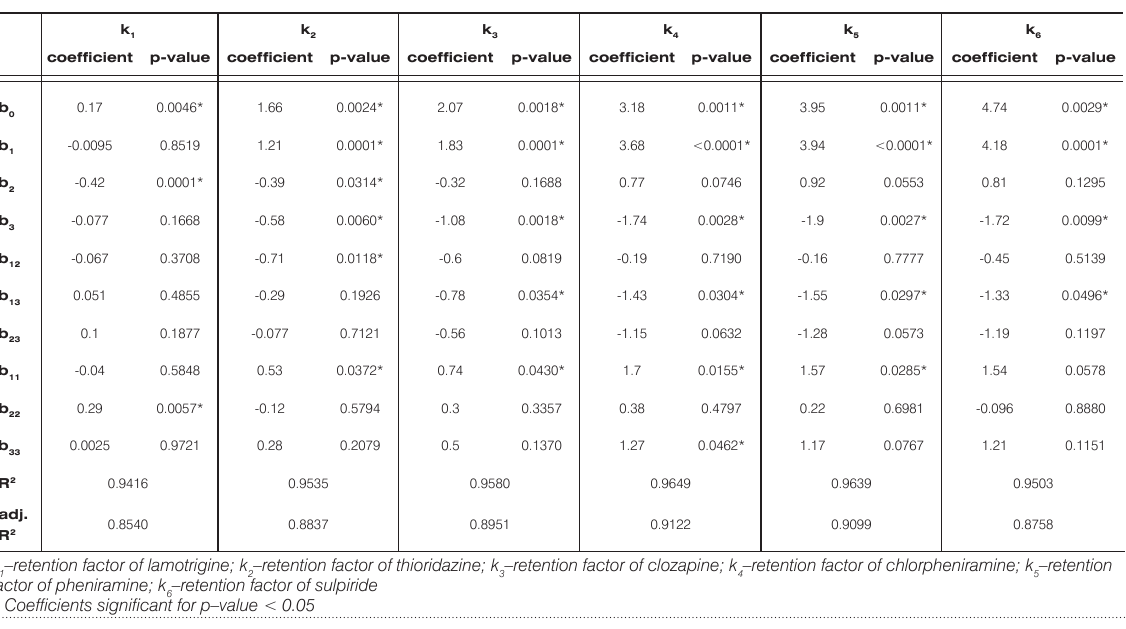
Table 4. Coefficients of quadratic model.